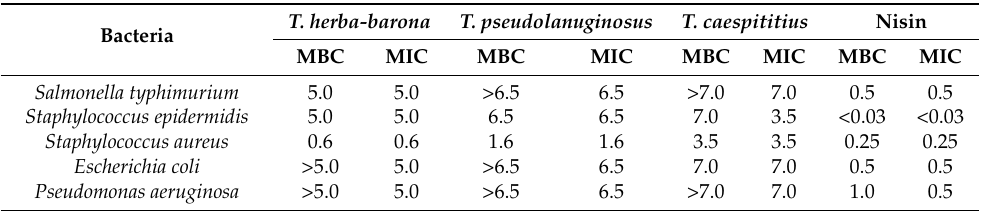
Table 3. MIC (mg/mL) and MBC (mg/mL) of plant extracts and nisin (mg/mL) against selected test